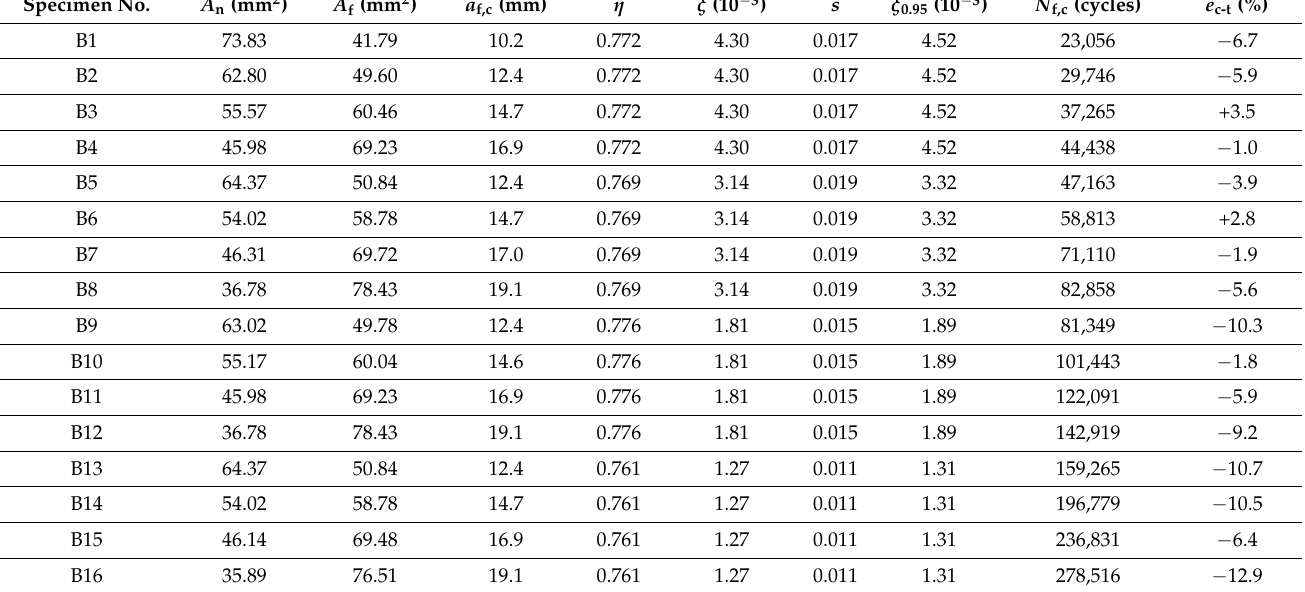
Table 4. Calibrated parameters of fatigue life calculation model of the notched plates. Specimen